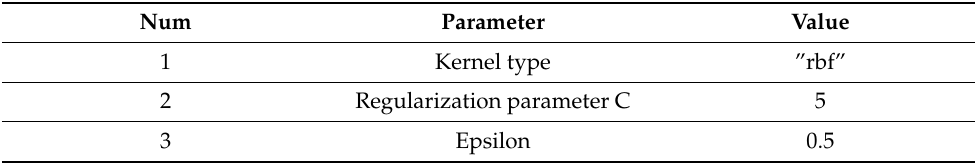
Table 8. Model parameters based on